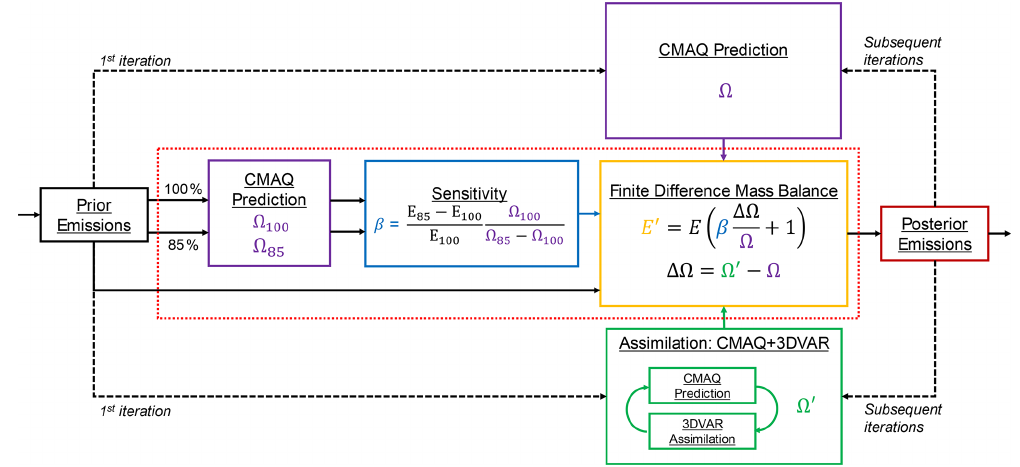
Figure 3. FDMB inversion. The red dashed line corresponds to the red dashed lines in Fig. 1, and the processes inside show additional details of the FDMB inversion. In this framework, the prior emissions (black box on the far left) are input to the CMAQ model. CMAQ simulations are performed with unperturbed prior emissions (100% arrow and E 100 ) and prior emissions with a − 15% perturbation (85% arrow and E 85 ). The resulting modeled VCDs are (cid:127) 100 and (cid:127) 85 , respectively. These VCDs are used to compute the sensitivity, β (blue box). New emissions totals are calculated with FDMB (yellow box), using β , NO 2 VCD from a CMAQ simulation without assimilation ( (cid:127) ), and NO 2 VCD from a CMAQ simulation with assimilation ( (cid:127) (cid:48) ). When iteration is used, the posterior emissions from the previous iteration are used as input to the CMAQ model to simulate new VCDs, (cid:127) and (cid:127) (cid:48)